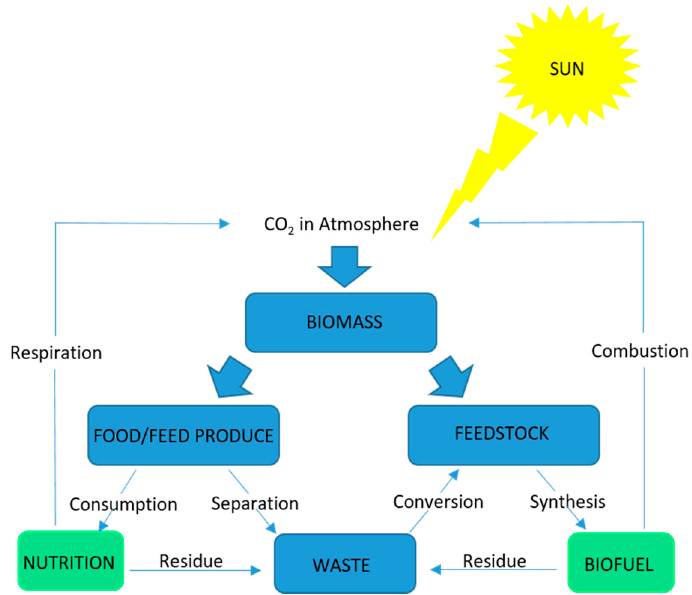
Figure 3. Main features of biomass energy technology.